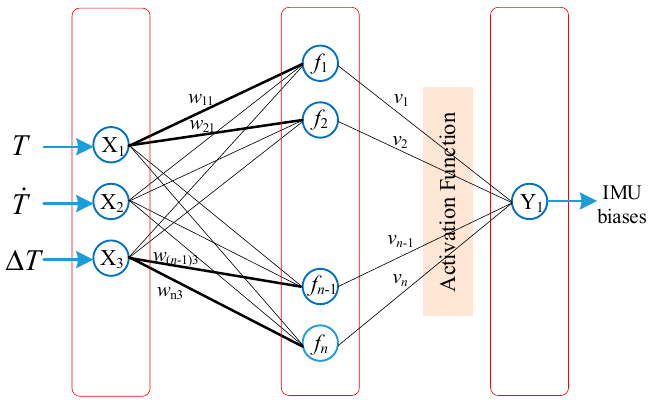
Figure 4. The BP network topology.